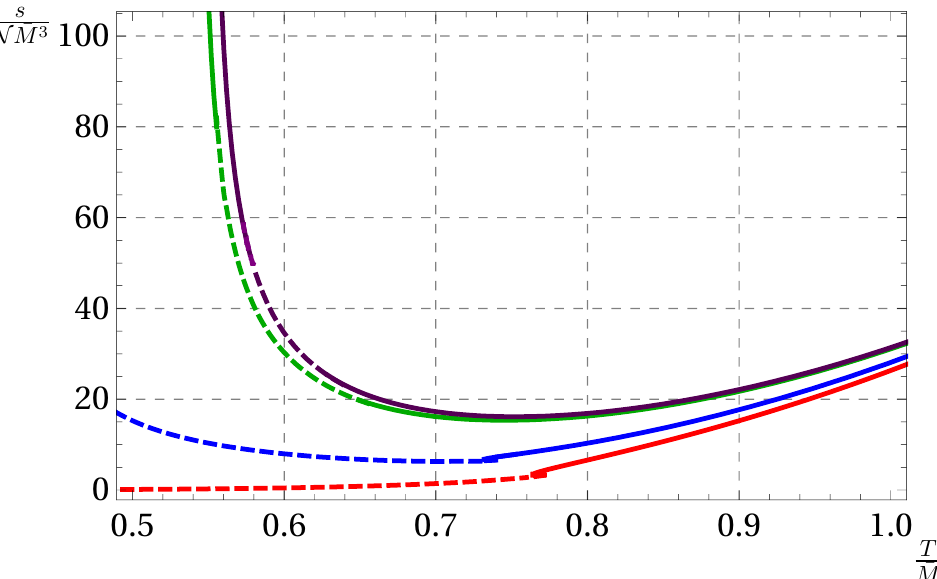
Figure 11 . Entropy density s= N (cid:22) M 3 as a function of T= (cid:22) M . Red, blue, green, and purple curves (bottom to top) correspond to b= (cid:22) M 2 = f 0 ; 2 ; 3 : 3 ; 3 : 4 g respectively. The dashed segments correspond to Minkowski embeddings, while the continuous segments correspond to black hole embeddings.